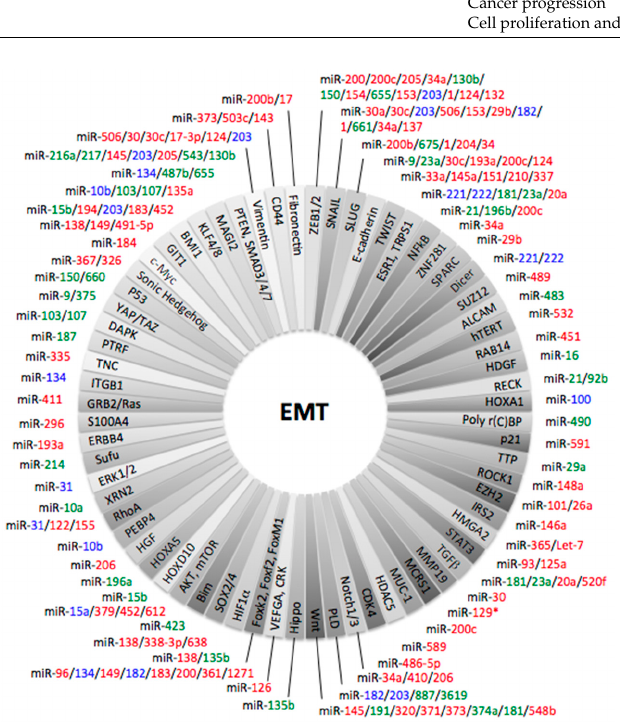
Figure 1. EMT regulation by miR in cancer, a complex network (Colour legend: green, promote EMT; red, suppress EMT; blue, controversial) (adapted from [117,205–210]).